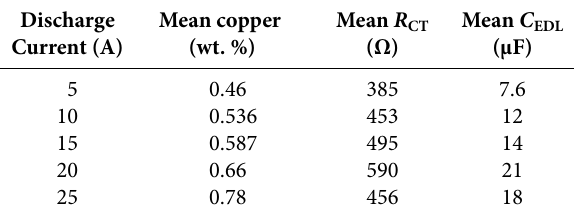
Table 9. The mean values of the diffused copper, R CT and C EDL in various discharge